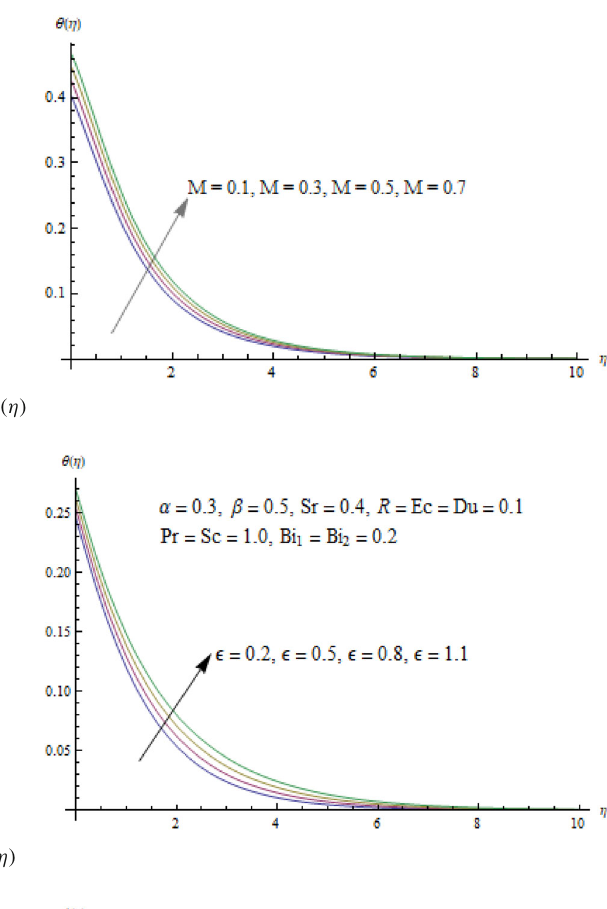
Fig. 11 Impact of (cid:2) on θ(η)